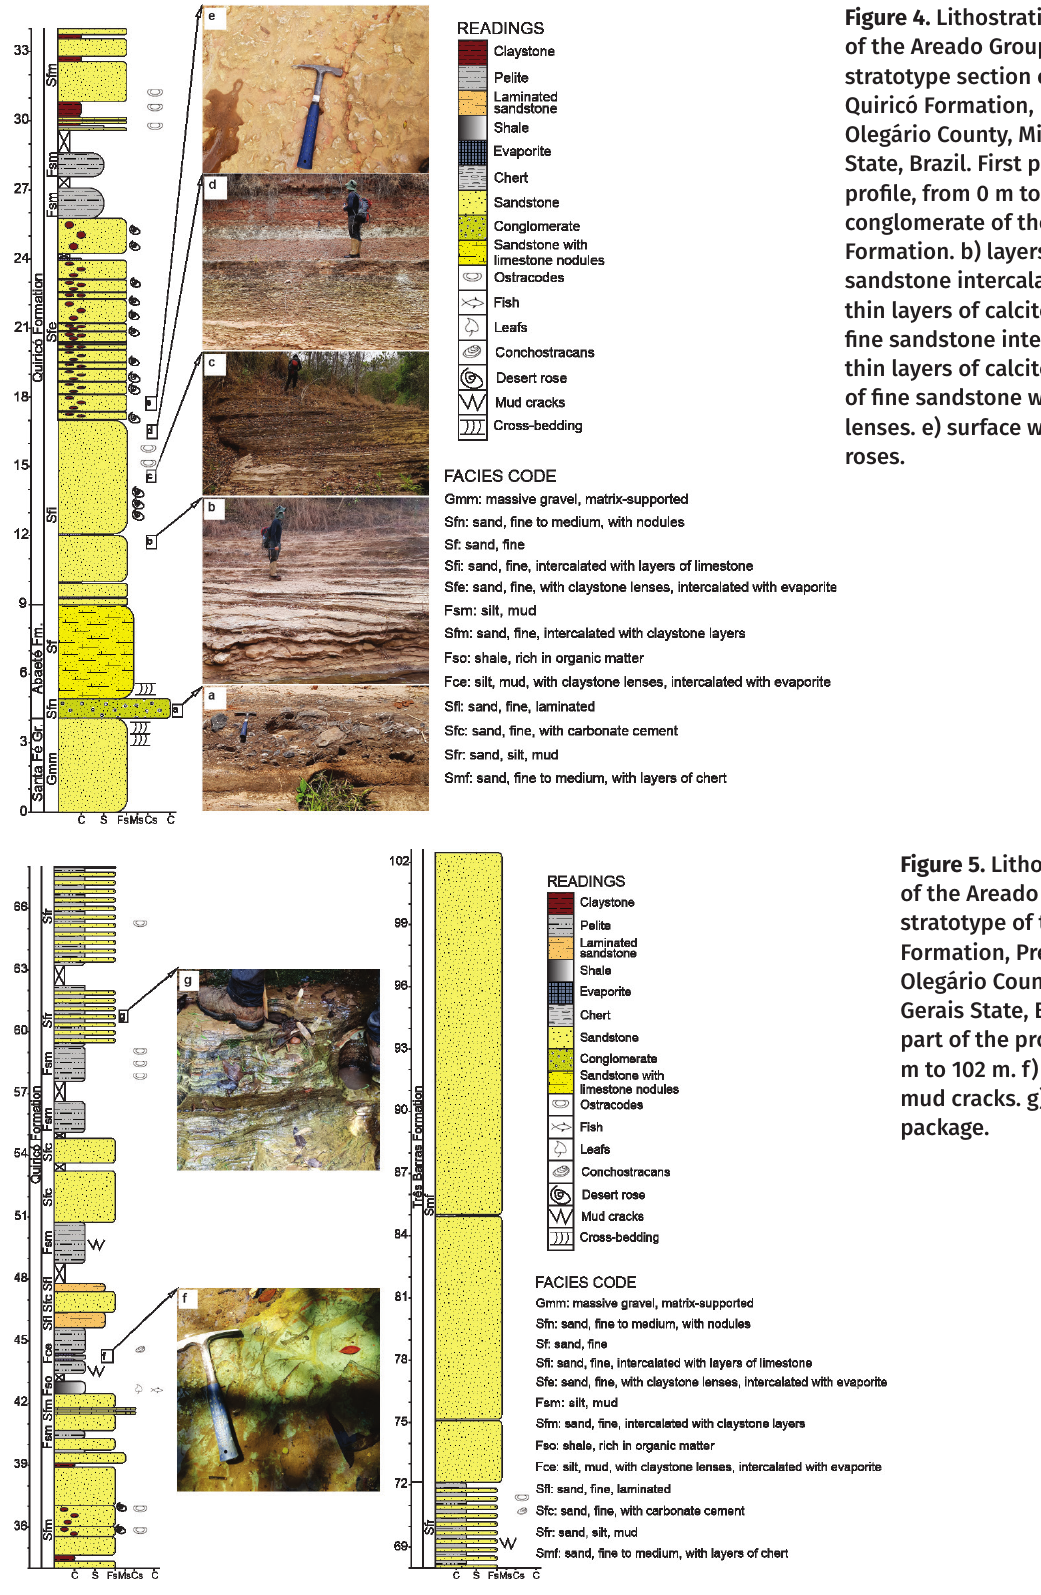
Figure 4. Lithostratigraphy of the Areado Group in the stratotype section of the Quiricó Formation, Presidente Olegário County, Minas Gerais State, Brazil. First part of the profile, from 0 m to 34 m. a) conglomerate of the Abaeté Formation. b) layers of fine sandstone intercalated with thin layers of calcite. c) layers of fine sandstone intercalated with thin layers of calcite. d) layers of fine sandstone with claystone lenses. e) surface with desert